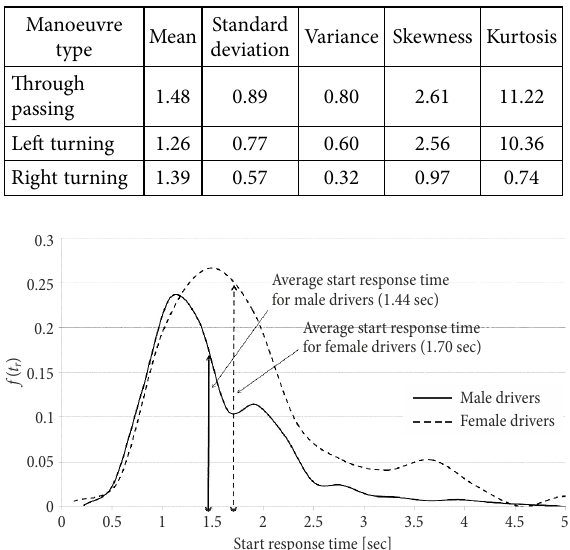
Fig. 5. Probability distribution plots of male and